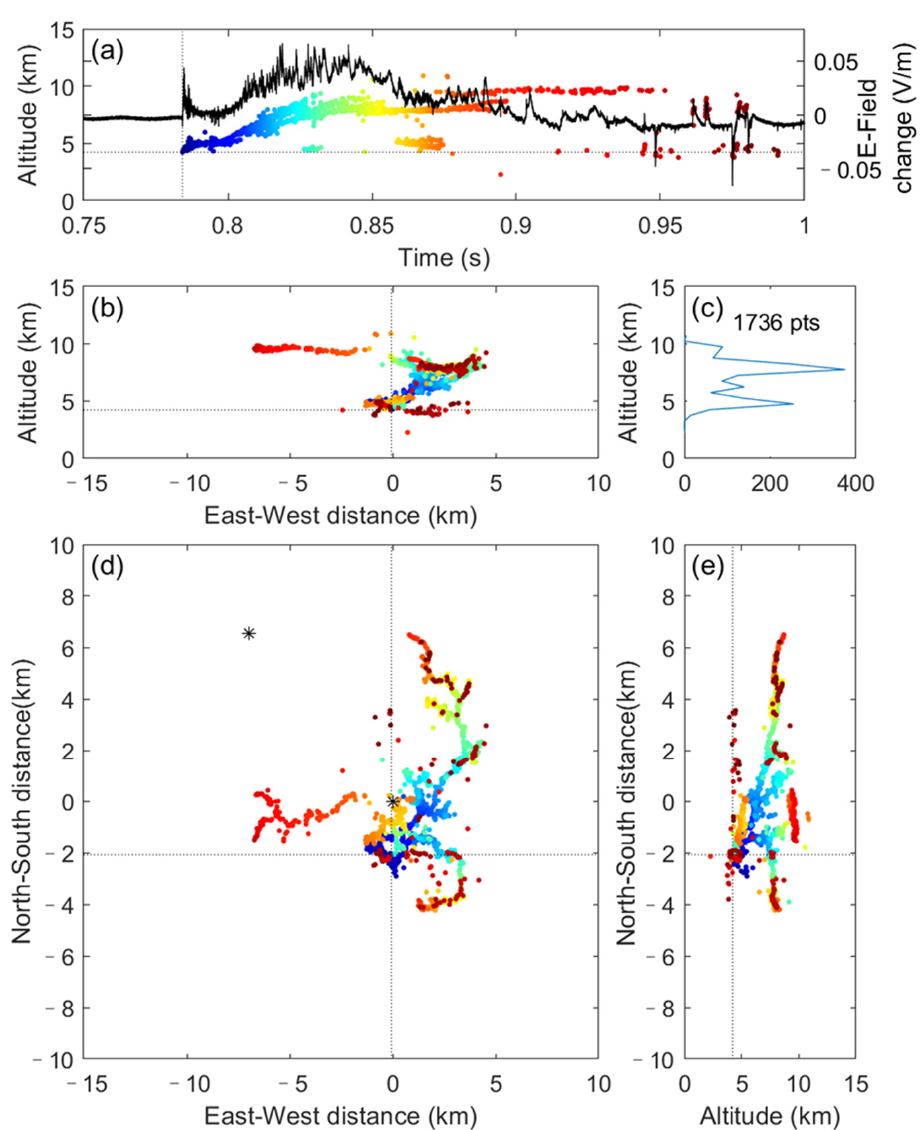
Figure 9. Three-dimensional location results of the preliminary breakdown process of the CG flash in Figure 8. ( a ) height with time, ( b ) north–south vertical projection, ( c ) height distribution of the number of radiation sources, ( d ) plane projection, and ( e ) east–west vertical projection of the three- dimensional location result. Asterisks are positions of the interferometer. Dashed lines intersect at the initiation point of the flash.